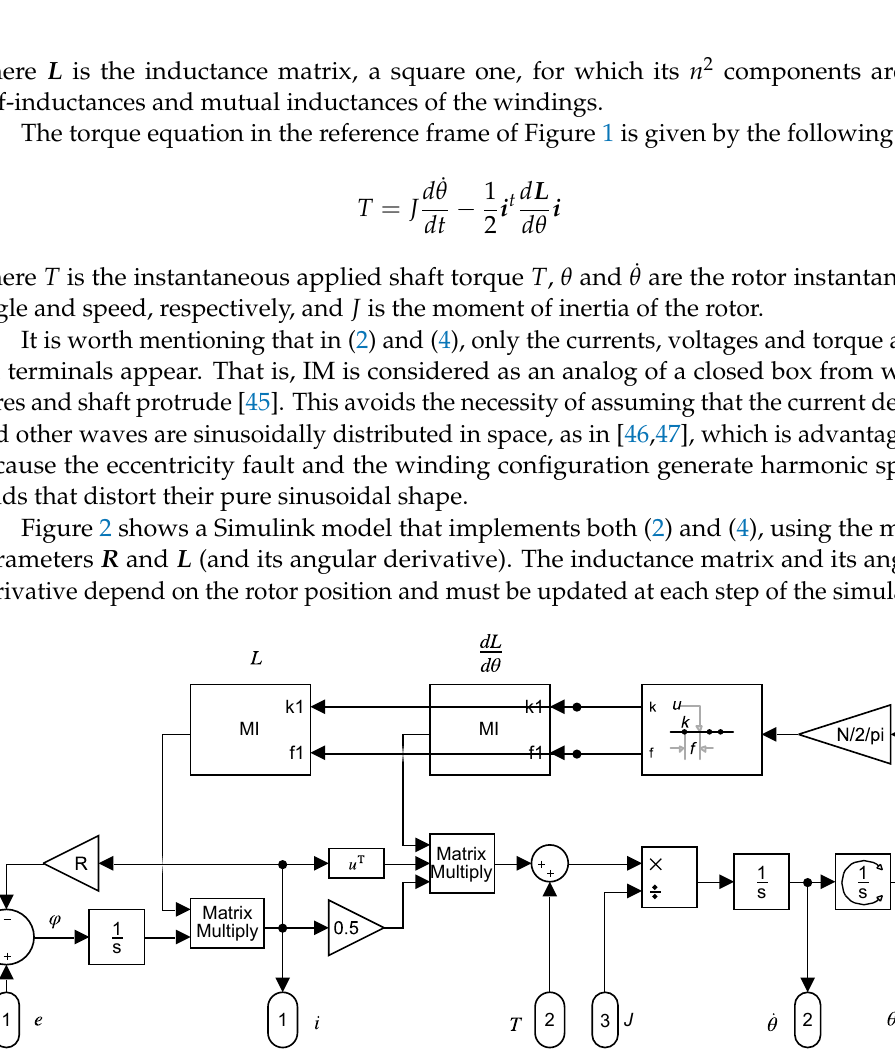
Figure 2. Dynamical model that implements (2) and (4) in Simulink. This model has three input ports: (1) the voltage vector e , (2) the applied shaft torque T , and (3) the moment of inertia of the rotor J . It has also three output ports: (1) the current vector i , (2) the rotor speed ˙ θ , and (3) the rotor angular position θ